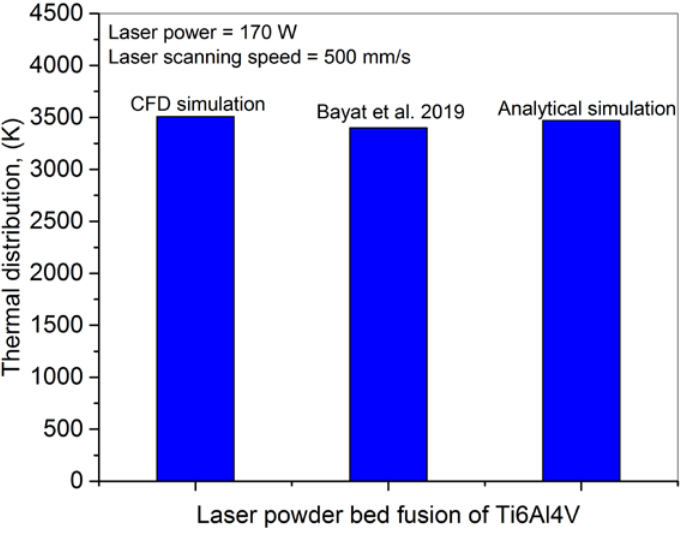
Figure 12. A comparison for thermal distribution among CFD simulation, literature result [58] and analytical computation for keyhole formation.